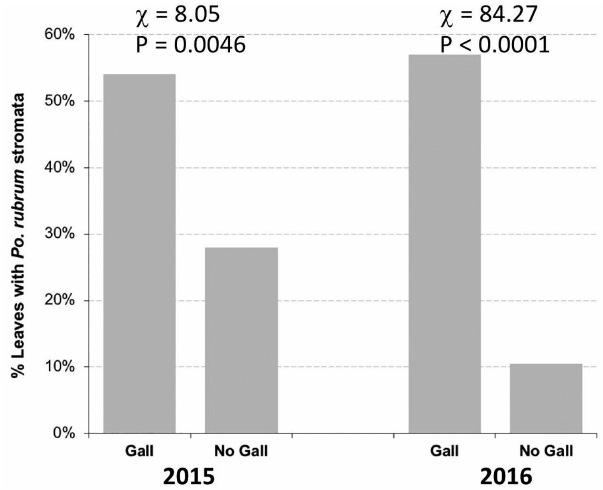
Figure 4 – Frequency of occurrence of Polystigma rubrum galls on leaves also infected with the gall mite Eriophyes prunispinosae or not. More stromata were observed on galled